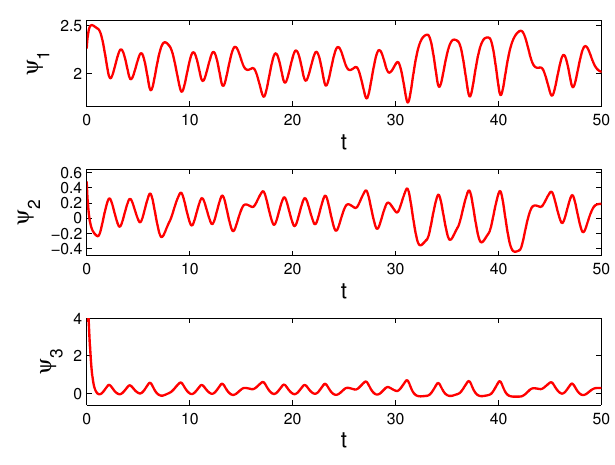
Figure 3. The time series of the coordinates ψ 1 , ψ 2 and ψ 3 of the solution of system (17) with the initial conditions ψ 1 ( 0 ) = 2.2610, ψ 2 ( 0 ) = 0.4815, ψ 3 ( 0 ) =